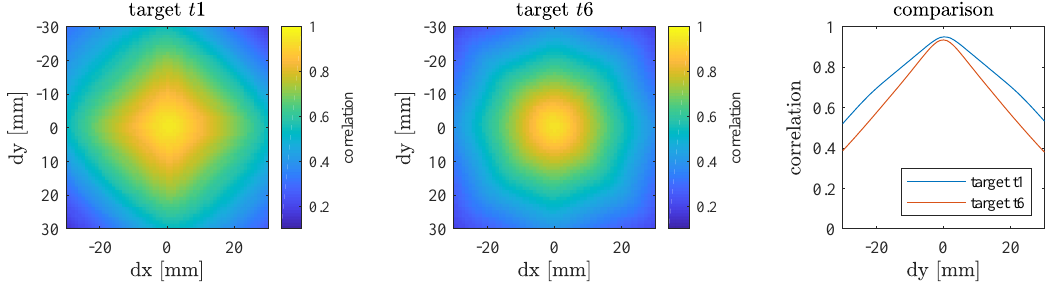
Figure 14. Left and middle : empirical correlation functions depending on the shift [ dx , dy ] for the target t 1 and the BOTA8 ( t 6), right : direct comparison between the two empirical correlation functions depending on the shift dy (scan distance: 50 m, incidence angle: 15 ◦